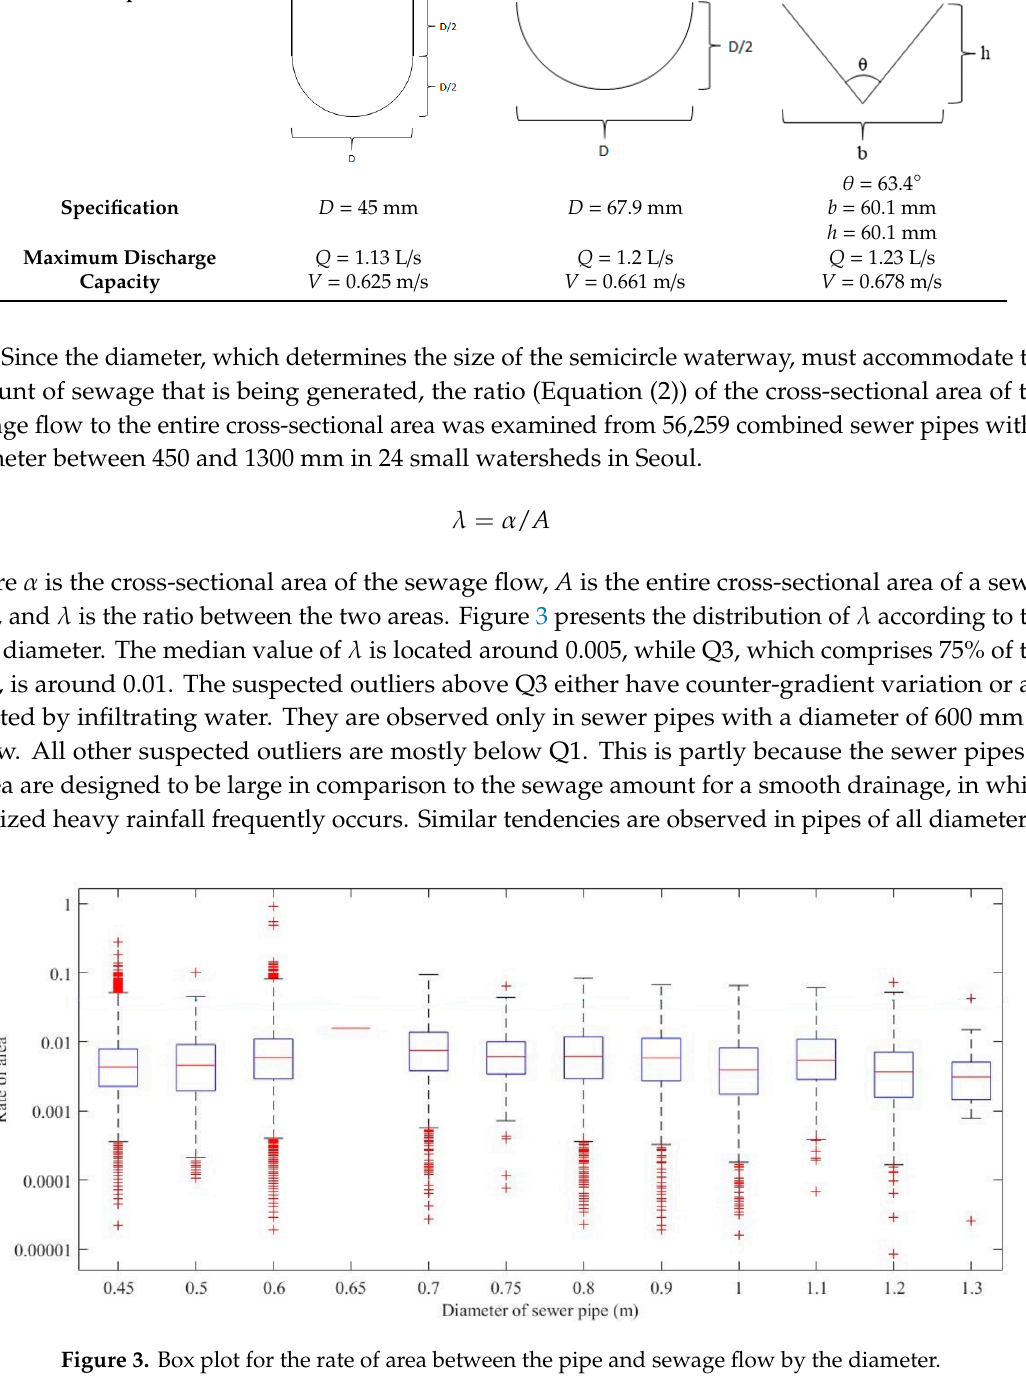
Table 1. Size and discharge capacity of the cross-section shapes under a common condition. Common Condition